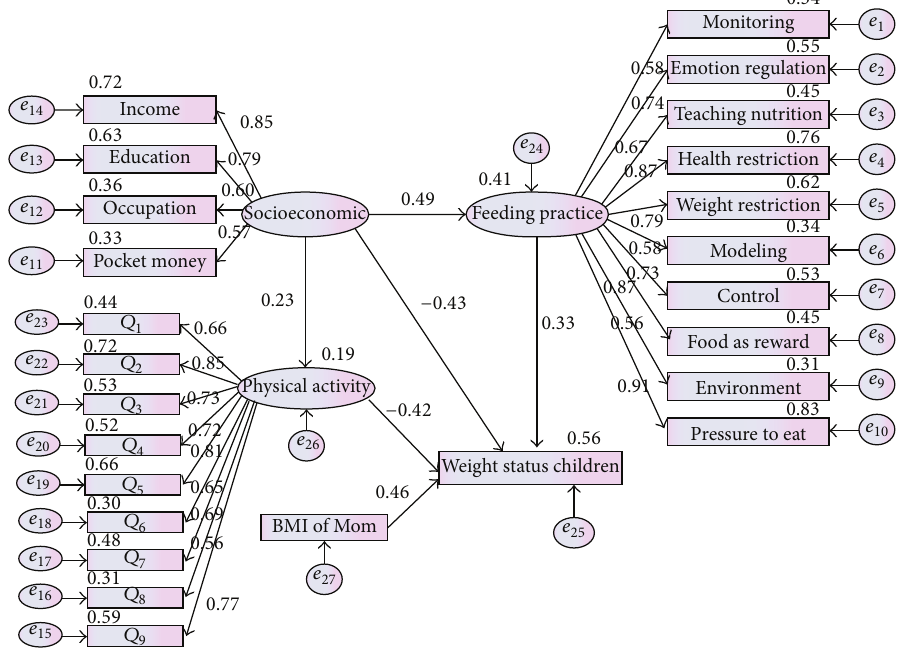
Figure 12: Comprehensive structural model with regression weight and covariance coefficients.